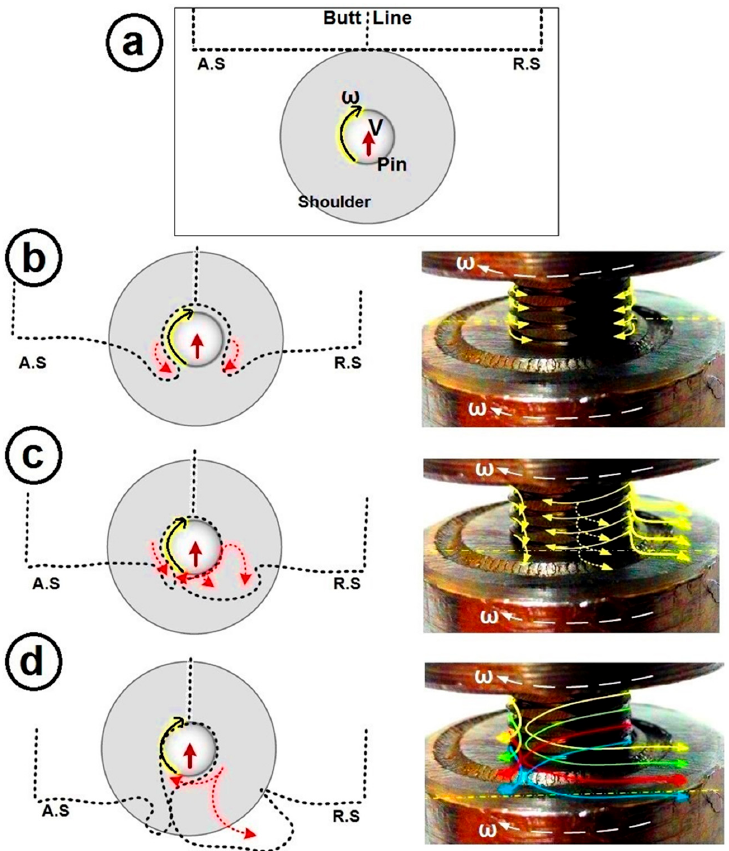
Figure 7. Schematic of formation of the entry region at the rear of the pin, ( a ) relative position of the tool and workpiece; ( b ) initial contact between the rotating tool and workpiece; ( c ) formation of the ejected spray by rotation of the tool inside the workpiece; and ( d ) final profile of the mass ejection and formation of the entry defect consisting of a curved tail, island zone and a nonbonding discontinuity (Left: Top view of the tool-workpiece interaction, Right: flow streamlines around the pin profile).